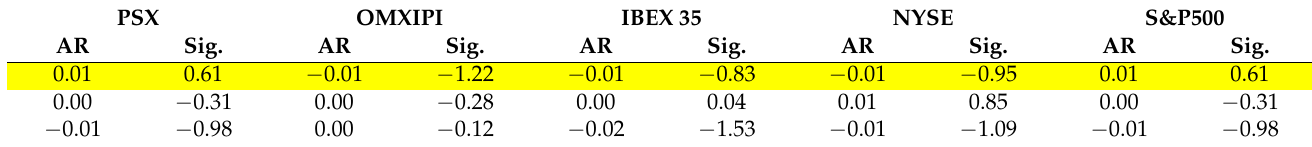
Table A6. Abnormal returns of the (0, +2) event window (News of Panama leaks).